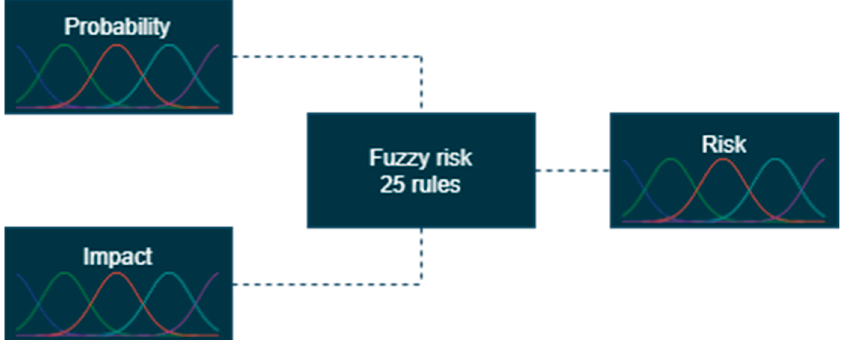
Figure 6. Fuzzy model inference structure.